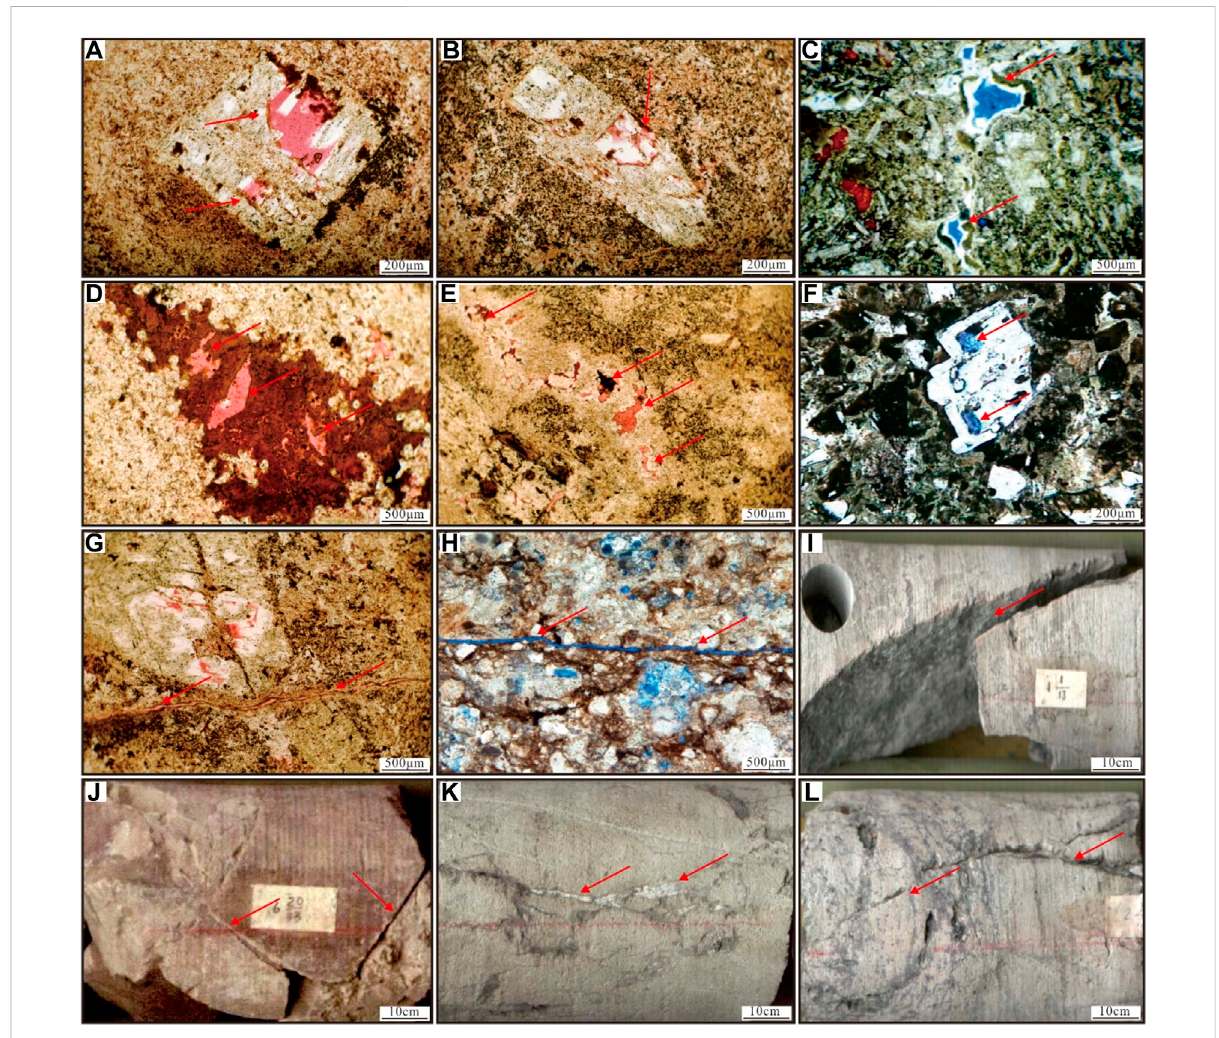
FIGURE 3 Types and characteristics of Carboniferous volcanic rocks reservoir space in Shixi Oil fi eld. (A) Primary pore, S001, 4502.90 m; (B) Primary pore, S001, 4501.75 m; (C) Intercrystalline pore, S004, 4382.00 m; (D) Intercrystalline pore, S001, 4519.97 m; (E) Dissolution pore, S001, 4524.50 m; (F) Dissolution pore, S004, 4368.70 m; (G) Micro shear fracture, S001, 4513.25 m; (H) Micro shear fracture, S004, 4392.16 m; (I) Shear fracture, S013, 4421.00 – 4421.10 m; (J) Shear fracture, S007, 4352.50 m; (K) Tensile fracture, S002, 4412.90 m; (L) . Weathering fracture, S013, 4421.10